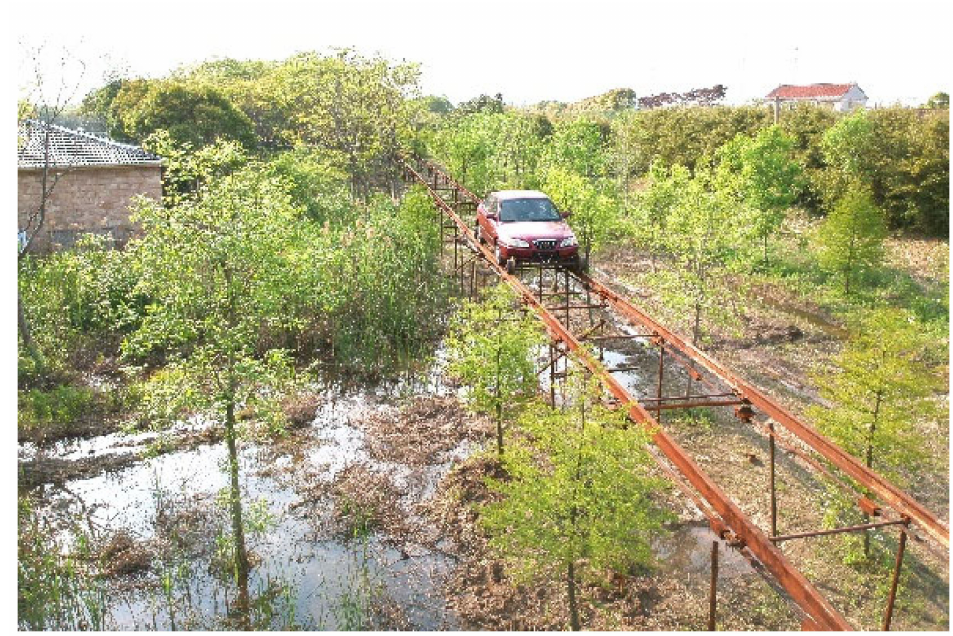
Figure 2. Full-scale model test